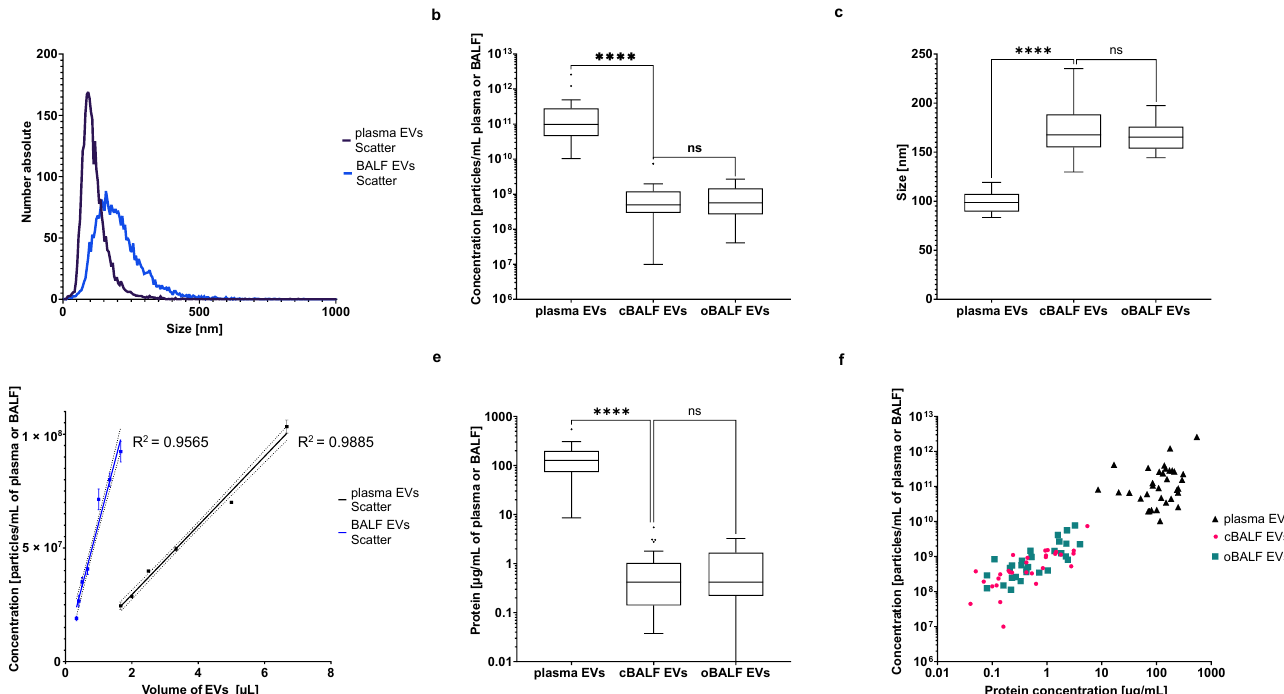
Figure 3. NTA of plasma and BALF EVs in scatter mode. ( a ) Distribution of number and size of detected particles in scatter mode of plasma and BALF-EVs. A representative NTA histogram of one patient is shown. ( b ) Mean concentration of EVs from plasma, cBALF, and oBALF for all patients. ( c ) Mode size of EVs from plasma, cBALF, and oBALF for all patients. ( d ) The concentration of particles measured in scatter mode depend on the volume of EV sample taken for the measurement. A line from simple linear regression with CI and R 2 was plotted for both types of EVs. ( e ) Protein concentration calculated for one mL of plasma or BALF. ( f ) Correlation between the concentration of particles and protein concentration for plasma and BALF-EVs. Graphs ( b , c , e ) present a Tukey plot for all patients. **** refers to p value ≤ 0.0001, ns refers to p value > 0.05 from the Wilcoxon test-paired comparison ( b , e ) and t -test-paired comparison ( c